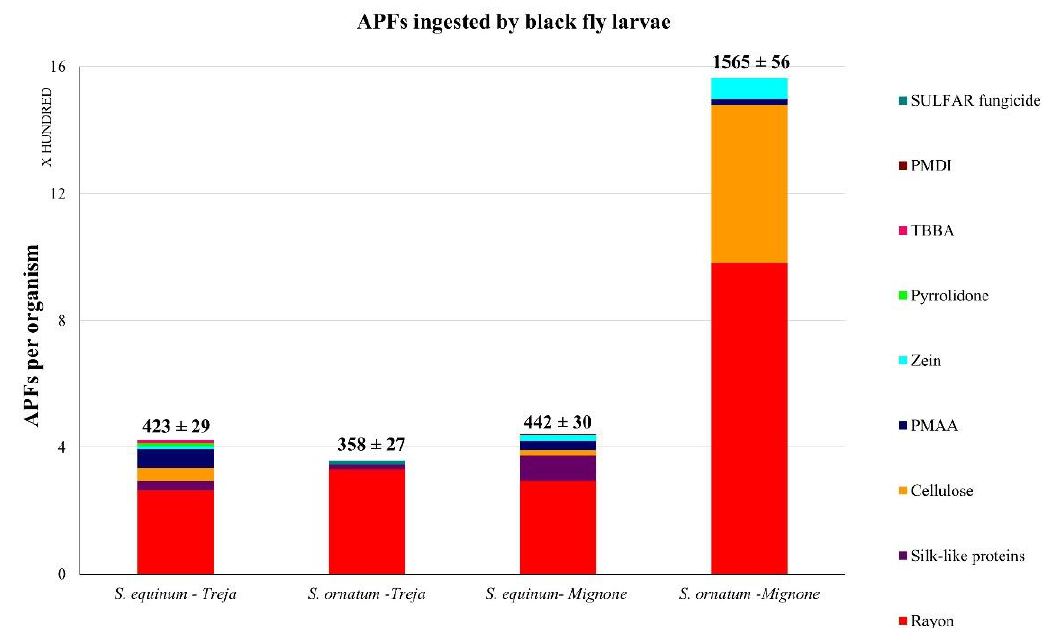
Figure 5. The average abundance of APFs per organism in the two species of blackfly larvae under exam, Simulium equinum and Simulium ornatum (20 organisms per species for each sampling site was analyzed). The distribution of ingested additives, plasticizers, and other microlitter components is also shown. Rayon is a non-plastic synthetic fiber, which is preeminent in all the specimens studied. Simuliidae can ingest larger particles if compressible; some rayon fragments in S. ornatum in the Mignone River were >150 µ m in length. The fiducial interval according to Poisson’s distribution is reported for each species in the sampling sites studied.